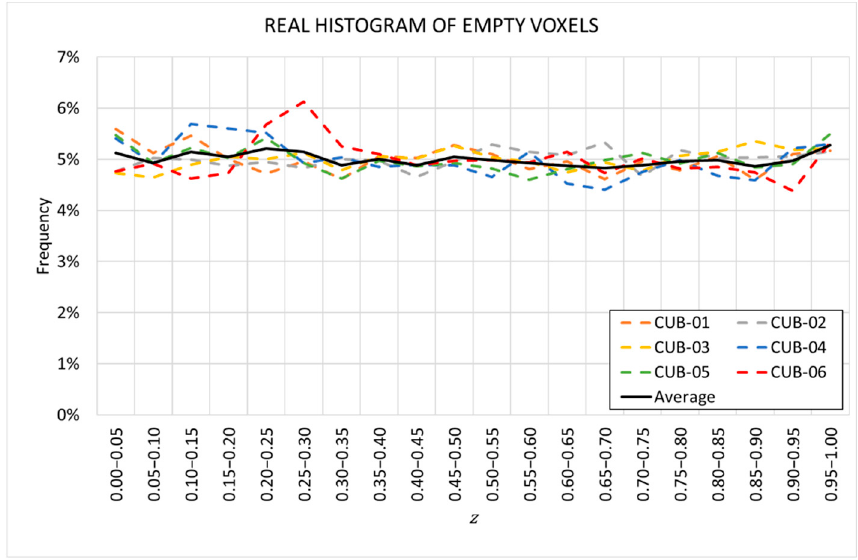
Figure 14. Vertical test. Real histogram of empty voxels.